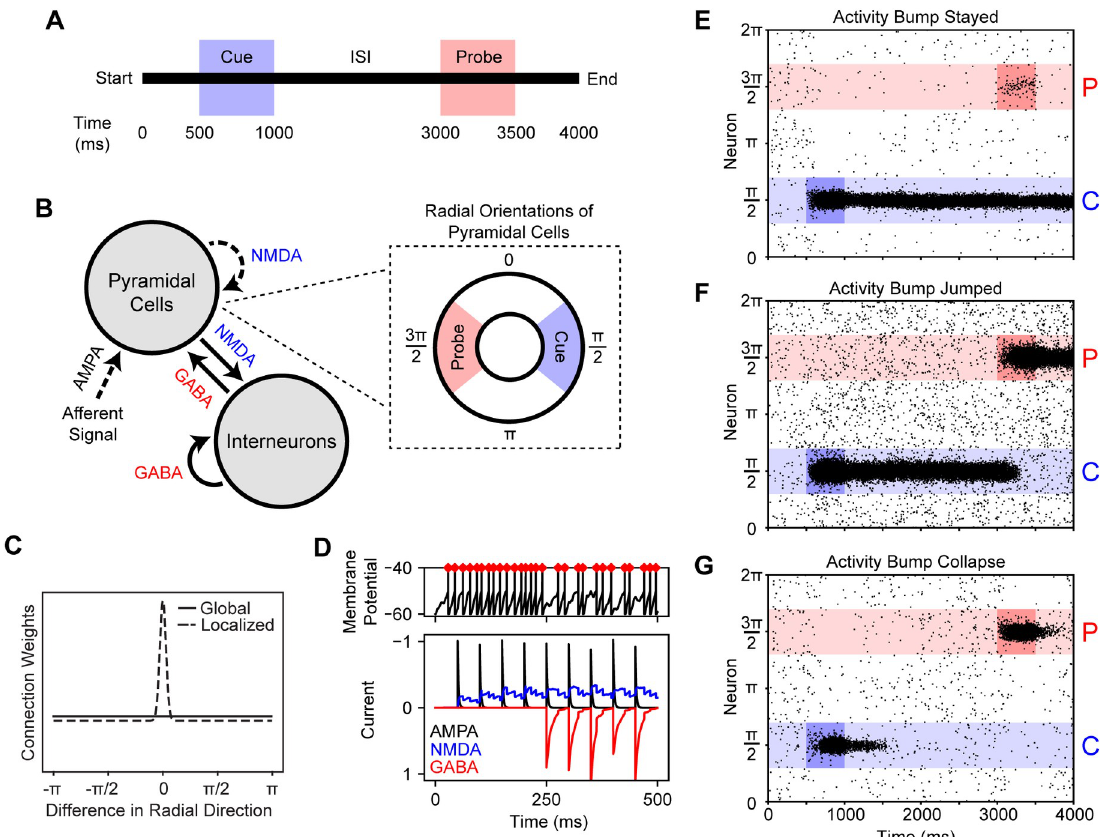
Fig 2. Simple cue-probe experiment and model design with example raster plots. A. Temporal structure of cue-probe trials. During each trial, the cue and probe were both presented for 500 ms at 500 and 3000 ms, respectively. B. Design of the ring attractor and important receptor subtypes for excitatory and inhibitory connections. The ring attractor consisted of 1024 pyramidal cells and 256 interneurons. The pyramidal cells were assigned radial directions and those near π /2 and 3 π /2 were associated with the cue and probe stimuli, respectively. Connections indicated with a dashed line were spatially localized whereas those indicated with a solid line were not. C. Plot of the weight distributions of localized and global connections. Localized weights were more strongly connected to pyramidal neurons with a similar radial direction. The difference between global inhibitory and localized excitatory connections resulted in the creation of activity bump [23]. D. An example of AMPA, NMDA, and GABA receptor currents and how those manifested as spiking activity. In this example, EPSPs were induced at a rate of 20 hertz for the entire duration and IPSPs were induced at a rate of 20 hertz starting at 250 ms. The introduction of the IPSPs reduced the spiking rate (red diamonds) shown in the top panel as the excitatory and inhibitory currents interacted. Leak and noise currents are omitted. E-G. Example raster plots that show how activity bumps are induced and represent the cue and probe. E. With activity bump maintenance, the neural representation of the cue stayed at π /2 despite afferent signal at 3 π /2 during the probe (NMDA g,pyr = 0.37 μ S, NMDA g,int = 0.33 μ S, AMPA g,Aff = 0.9 μ S). F. In the case of activity bump jumps, the neural representation switched from the cue to the probe (NMDA g,pyr = 0.37 μ S, NMDA g,int = 0.30 μ S, AMPA g,Aff = 0.9 μ S). G. The activity bump can also collapse prior to probe presentation (NMDA g,pyr = 0.33 μ S, NMDA g,int = 0.30 μ S, AMPA g,Aff = 0.9 μ